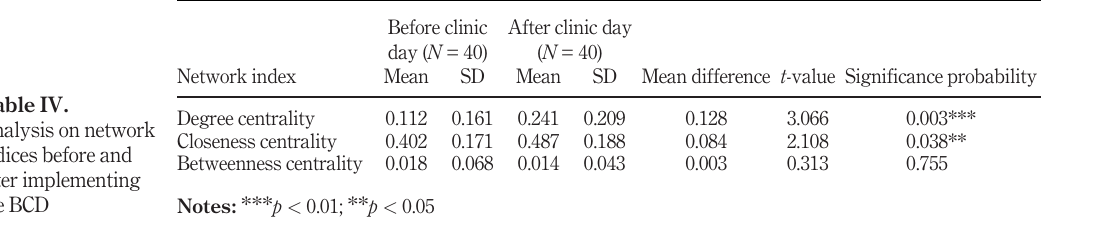
Table IV. Analysis on network indices before and after implementing the